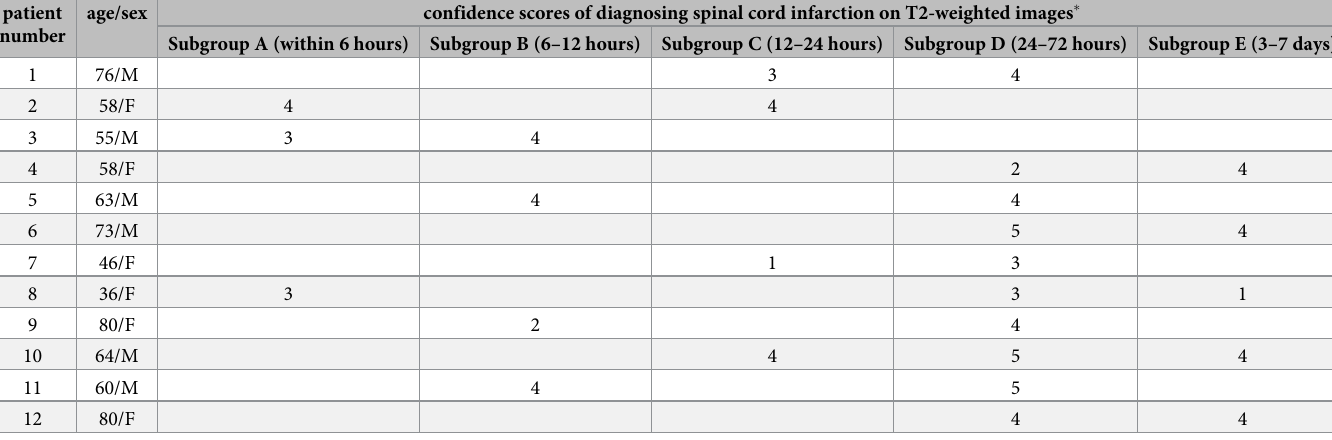
Table 4. The confidence scores for diagnosing spinal cord infarction on T2WI in patients of different spinal cord infarction subgroups who underwent MRI scans at more than two different time points. patient age/sex confidence scores of diagnosing spinal cord infarction on T2-weighted images � number